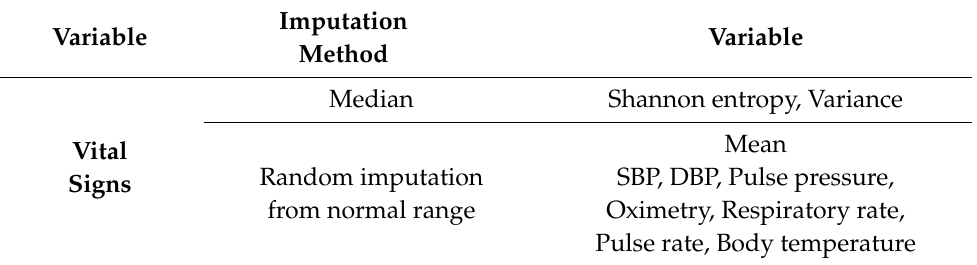
Table 4. Missing Value